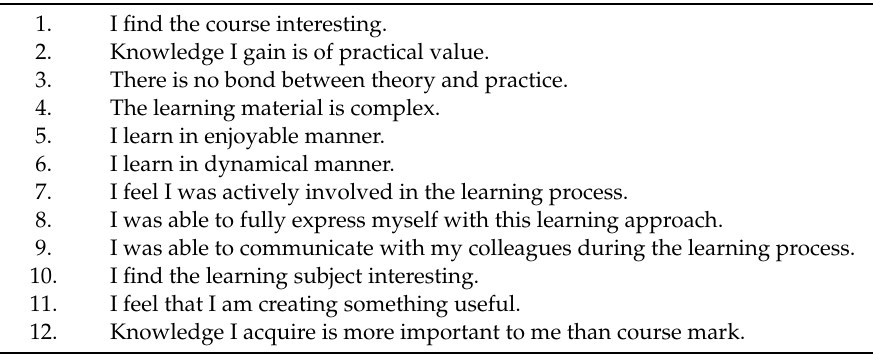
Table A1. Questionnaire for measuring student